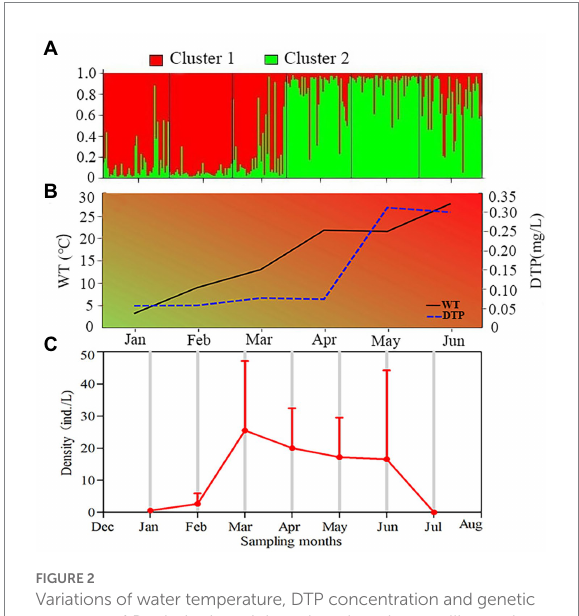
FIGURE 2 Variations of water temperature, DTP concentration and genetic structure of Daphnia sinensis based on the microsatellite markers during 6 months in Lake Chaohu. (A) The genetic structure of six modern D. sinensis groups. Each individual is represented by a vertical line, and two colors reflect the Bayesian cluster (assignment probability for K = 2). (B) The black line represents water temperature (WT), and the blue dotted line represents dissolved total phosphorus concentration (DTP). The Abbreviations are used for the months in the plot. (C) : The temporal distribution of D. sinensis density from January to July 2016.